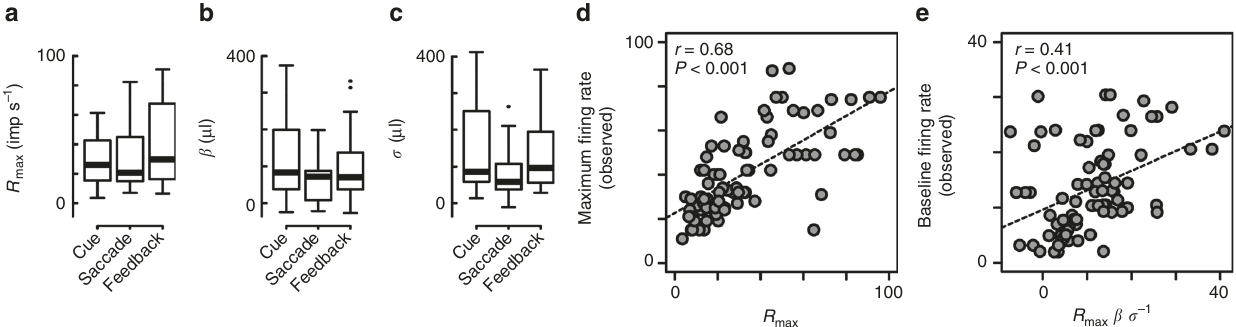
Fig. 6 Comparison of the estimated normalization parameters and observed fi ring rates. a – c Box plots of the estimated parameters in the advanced fractional model. The R max , β , and σ were plotted separately during three task periods. d Plots of the maximal fi ring rate observed in each mOFC neurons against the estimated R max . e Plots of the baseline fi ring rate observed in each mOFC neurons against the model output with no value information ( R max β σ − 1 ). Dashed lines in d , e indicate regression slopes. Correlation coef fi cients and statistical signi fi cance are shown